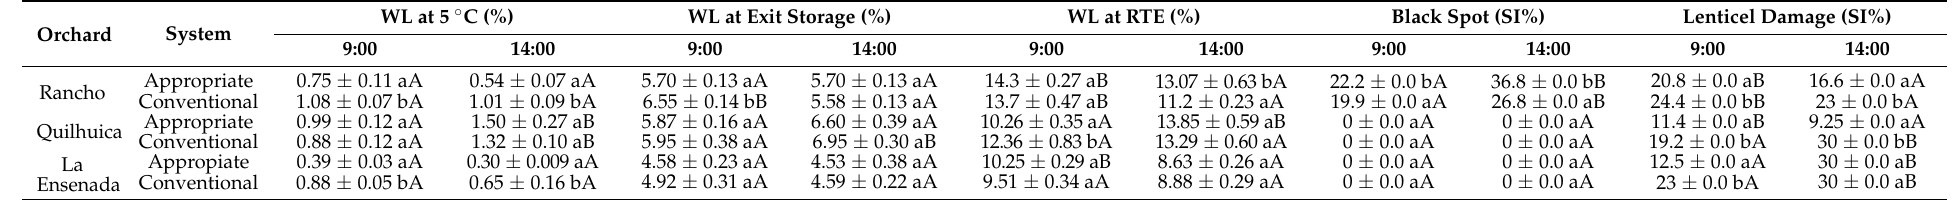
Table 1. Means followed by standard errors of the mean of weight loss (WL) at 5 ◦ C, at exit of the storage, at the ready-to-eat (RTE) stage, severity index (SI%) of black spot and lenticel damage from each orchard evaluated in an independent form at early harvest. Tukey HSD ( p < 0.05) test was used as a mean comparison test. Lowercase letters compare differences between the harvest systems (i.e., appropriate and conventional) in rows, and uppercase letters compare the differences between the harvest time (i.e., harvest at 9 h and 14 h) in columns for each variable evaluated in an independent manner.